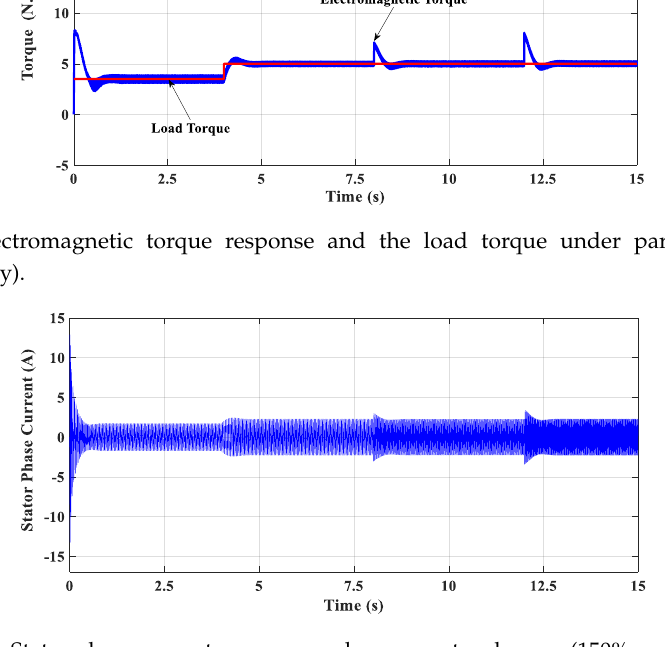
Figure 17. Stator phase-current response under parameter changes (150% uncertainty).